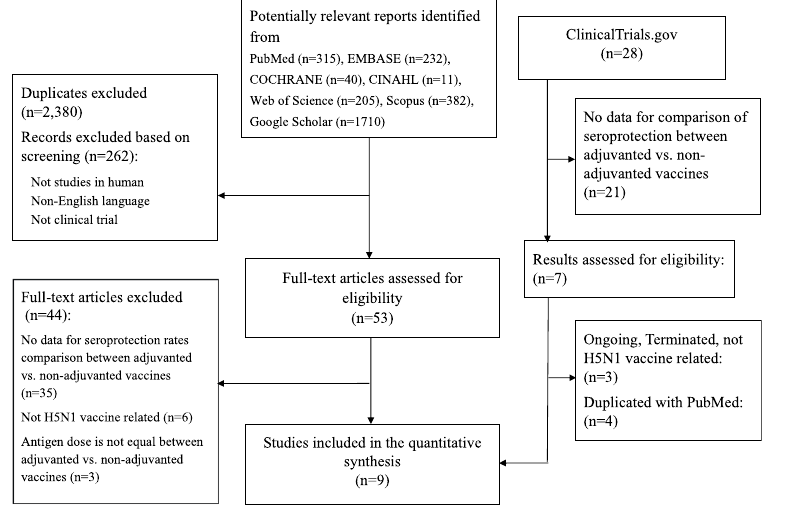
Figure 1. Flowchart of the literature